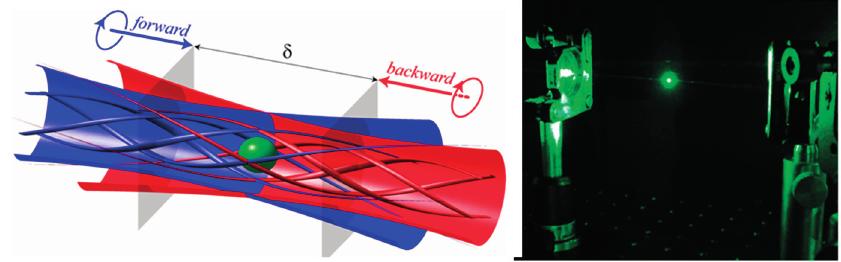
Figure 3. An example of a photophoretic trap. The particle is trapped in the low intensity region between two counter-propagating Laguerre-Gaussian vortex beams [21] (Fair Use according to